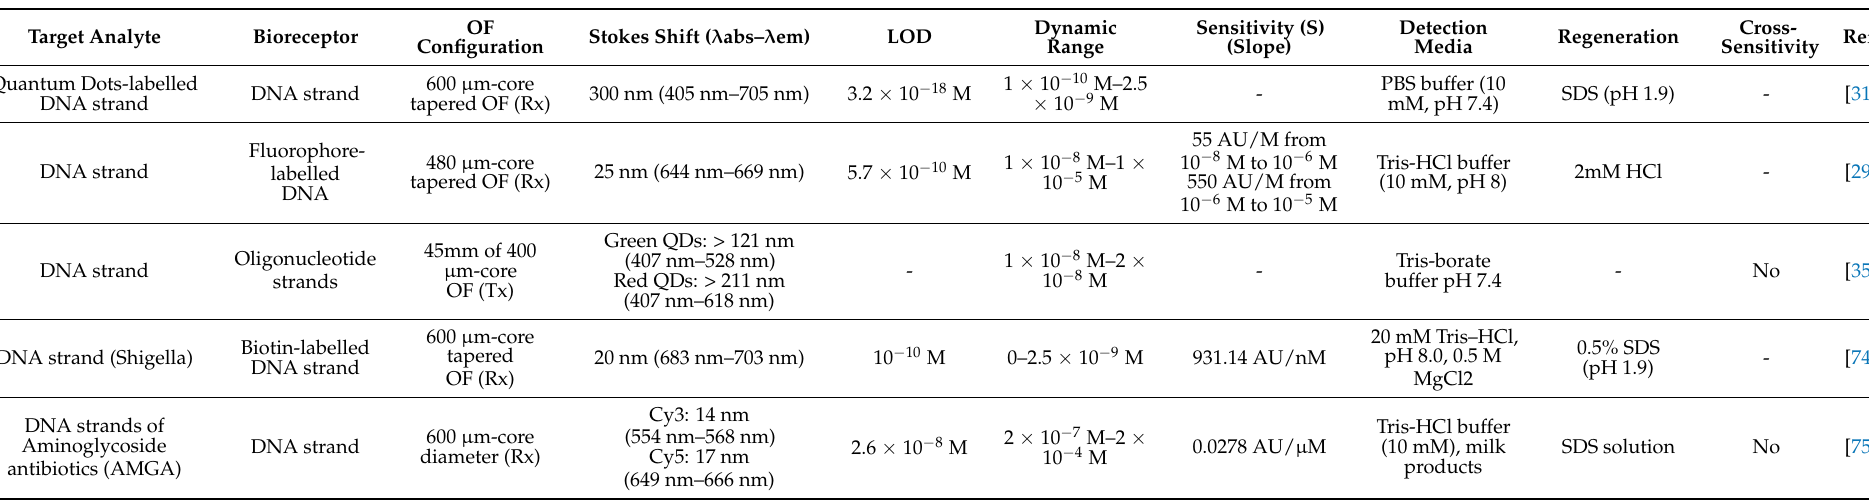
Table 1. Optical fiber biosensors based on luminescence using DNA strands or aptamers as bioreceptors for the detection of DNA strands. The dash indicates that information about that parameter is not available in the original manuscript.